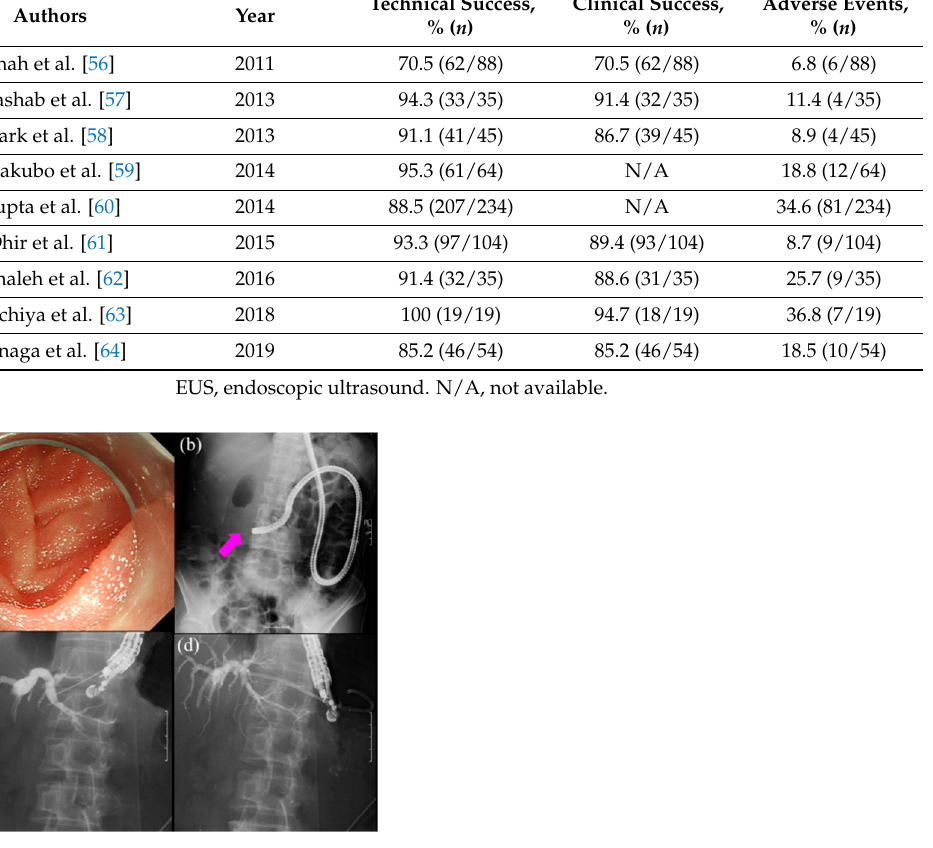
Table 4. Outcomes of endoscopic ultrasound (EUS)-guided biliary drainage.